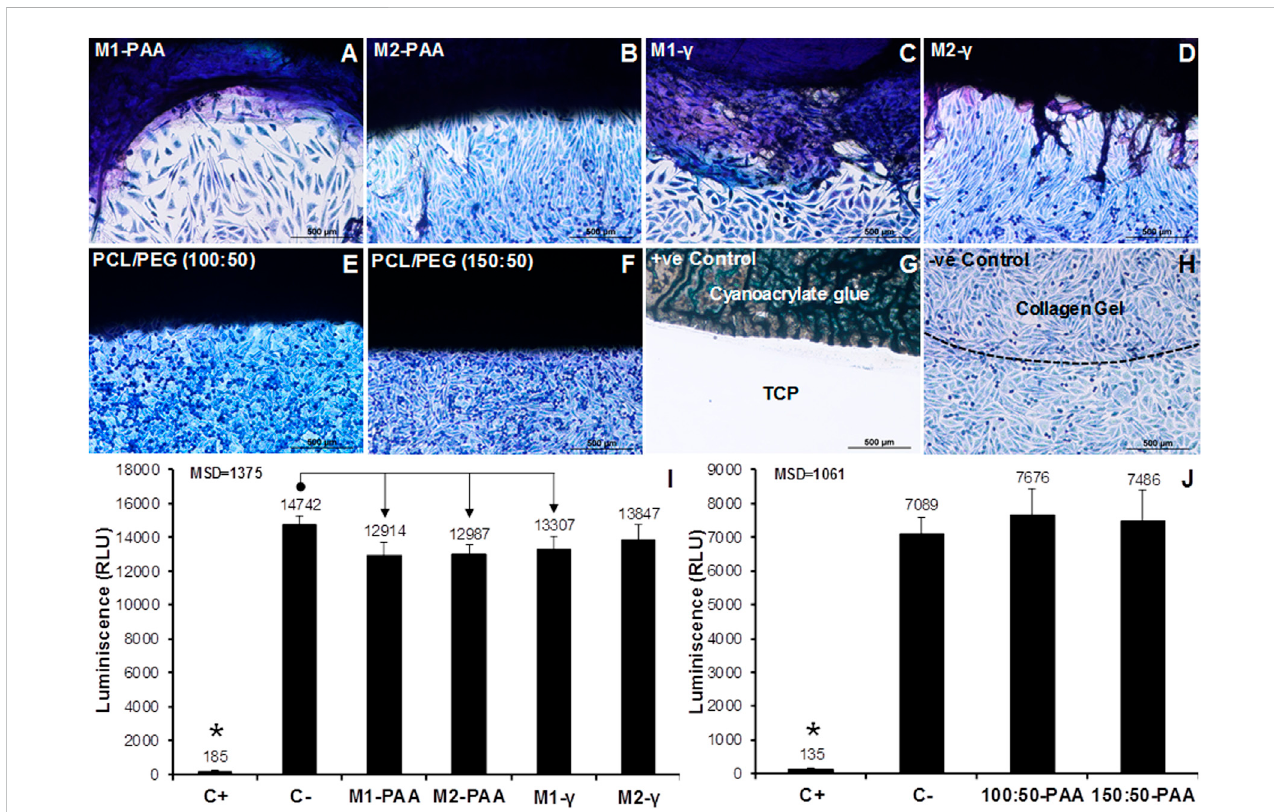
FIGURE 5 Contact (A – H) and extract (I,J) cytotoxicity results of the decellularized PTA scaffolds treated with (M2; (B,D,I) or without (M1; (A,C,I) RNase/DNase and sterilized with either PAA (A,B,I) or γ -irradiation (C,D,I) , together with the corresponding results for the 150:50 (E,J) and 100:50 (F,J) electrospun polymeric sleevessterilized withPAA. The contact cytotoxicity (A – H) was performed with L929murine fi broblasts,whichwerestained with Giemsa. Cyanoacrylateglue and collagen gel served as the positive (+ve) and negative (-ve) control, respectively. Scale bars indicate 100 μ m. No contact cytotoxicity effects were observed with either the decellularized scaffolds or polymeric sleeves. The extract cytotoxicity assay (I,J) was also performed with L929 murine fi broblasts with80%(v/v)DMSOandRPMI1640medium servingaspositive(C+)andnegative(C − )controls, respectively.Luminescencewasexpressedasmeans( n =6); error bars indicate 95% C.I.; MSD: minimum signi fi cant difference; indicates signi fi cant difference between the native and decellularized groups. Connectors indicate signi fi cant difference between originator and end arrow